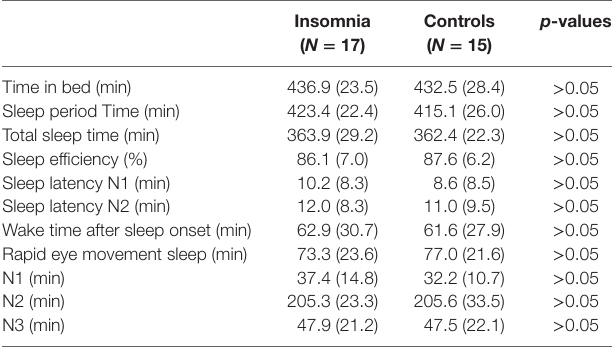
TaBle 2 | Macro structure of